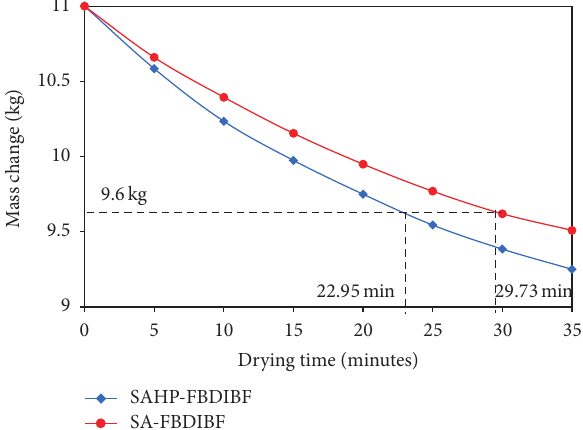
Figure 12: The variation of temperature and efficiency of biomass furnace with drying time.